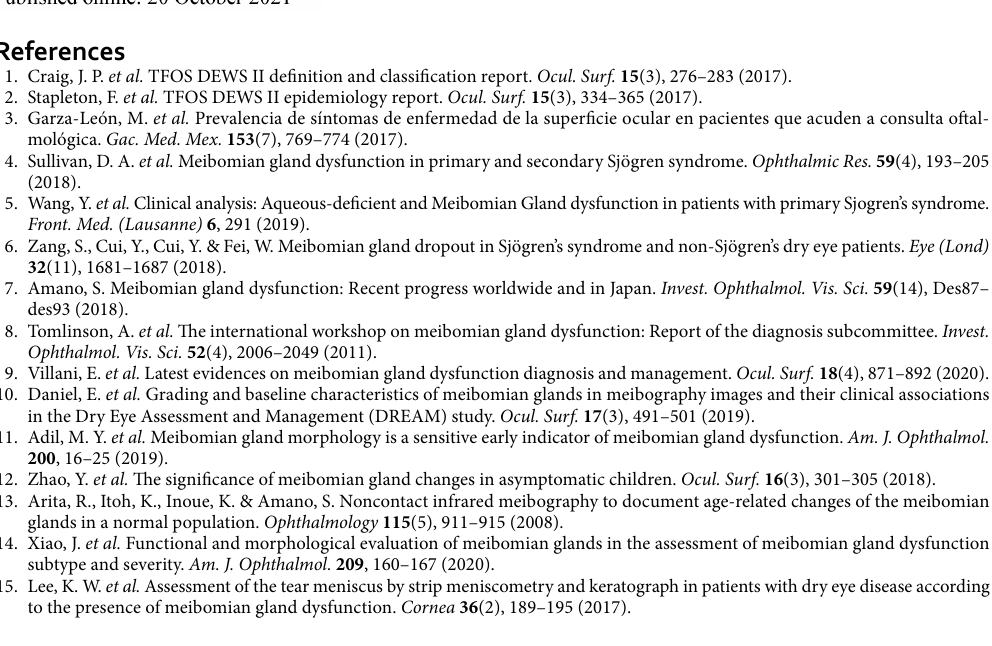
Figure 3. Quantification the percentage of MG loss with the Phoenix software (version 3.2, Construzionne Strumenti Oftalmici, Firenze, Italy), green area: eyelid area with meibomian glands, red area: area with lost of Meibomian